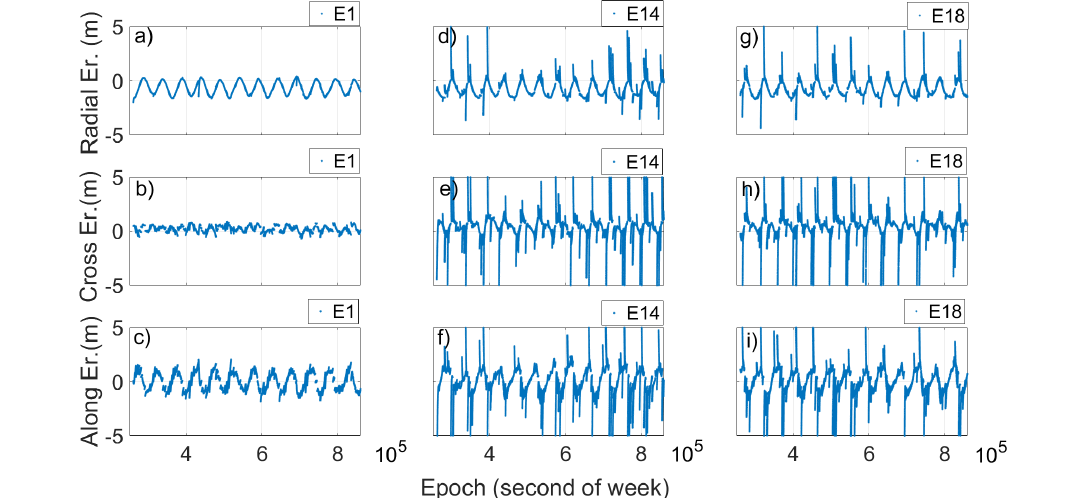
Figure 5. Radial, cross and along error for satellite 1 (E1), Milena (E14) and Doresa (E18) satellites plotted versus time. The ephemeris validity time is 14,400 s (4 h). To have a better readability for ( d – i ), the maximum value of errors is limited to 5